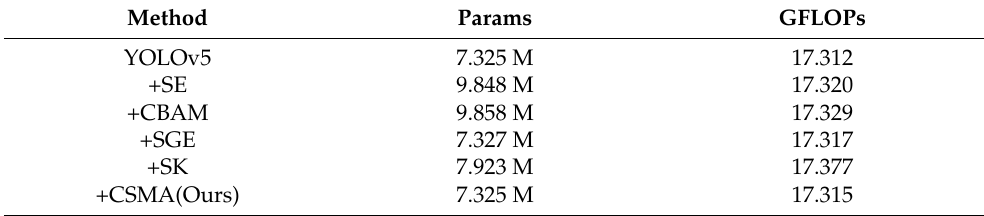
Table 1. Object Detection Result of Different Attention Method in VisDrone-DET2021 Dataset.